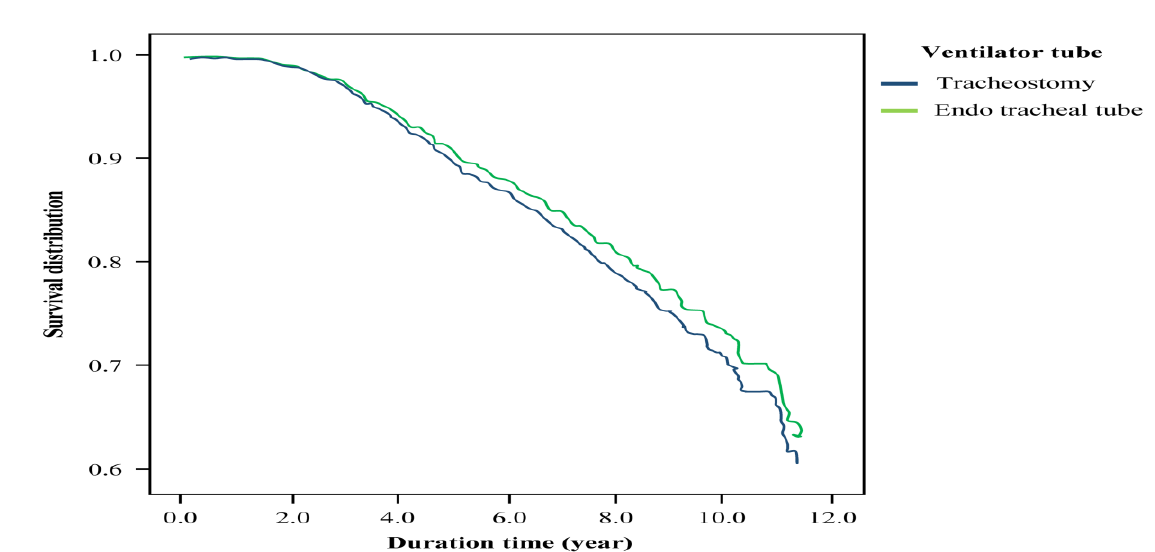
Figure 1. Survival curve of patients with PMV. Table 2. Descriptive analysis of survival in patients with tracheostomy and translaryngeal intubation ( n = 1342).